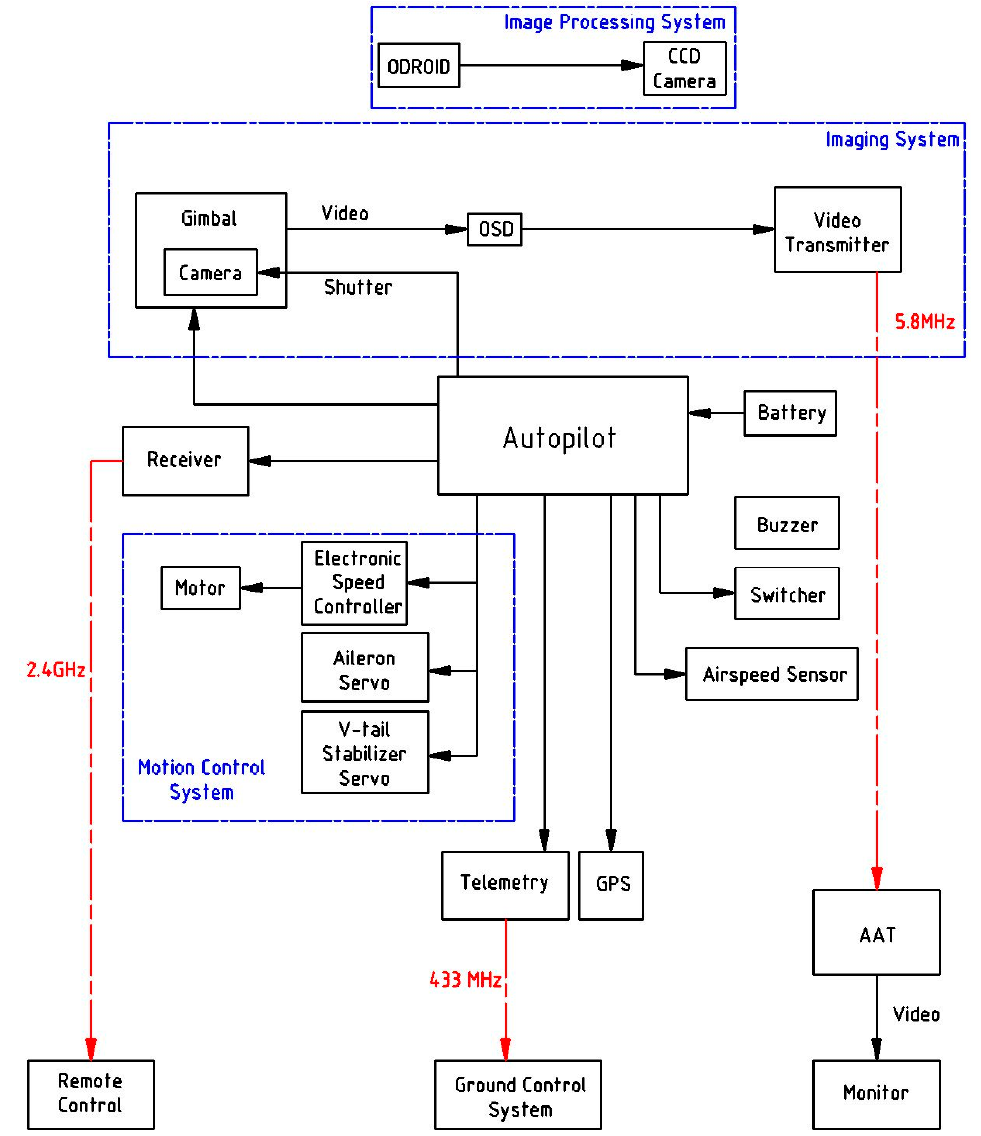
Figure 2. Systematic framework of the UAV system.